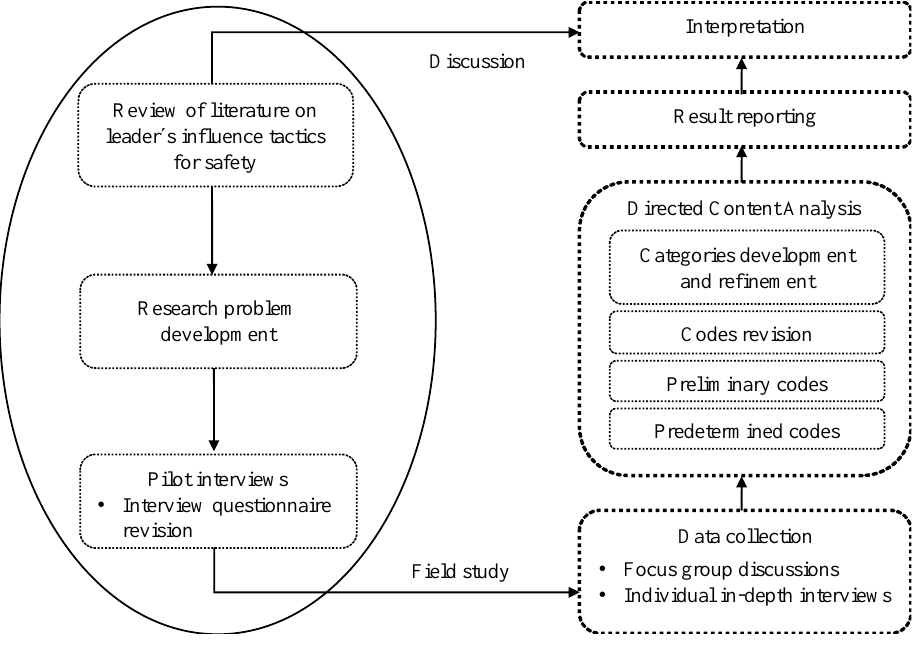
Figure 2. Methodological approach.